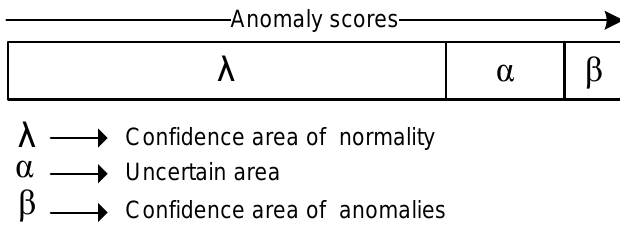
Figure 2. The categorization of unlabelled data after applying the anomaly-scoring